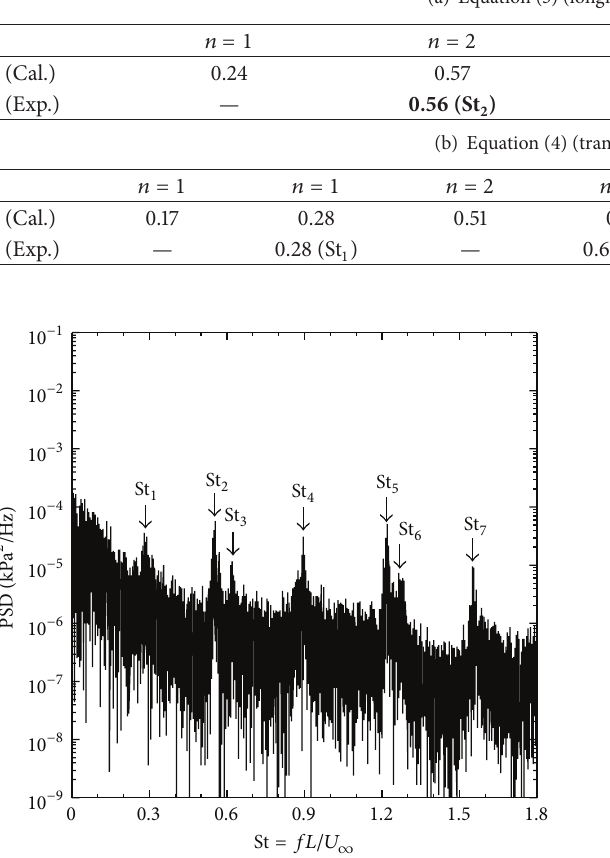
Table 3: Strouhal numbers of pressure oscillations resulting from feedback mechanisms for 𝐿/𝐷 = 1.8 .